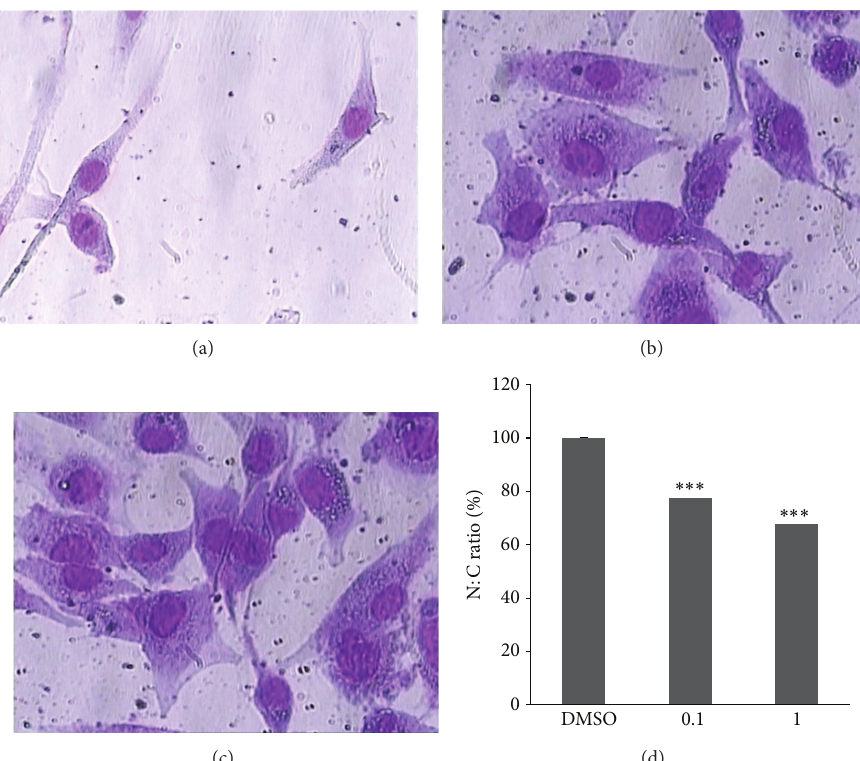
Figure 2: Morphological changes and N: C ratio analysis of 8305C cells following 0.1 and 1 mmol/L VPA treatment for 96h. (a) Untreated control cells (DMSO) showed spindle and mesenchymal morphology. (b) and (c) 0.1 and 1mmol/L VPA treated cells showed oval-round to polygonal morphology (magnification 40x). (d) High N: C ratio of the untreated cells decreased dramatically in VPA treated cells. Data are shown as mean ± SD. ∗∗∗ 𝑃 < 0.001